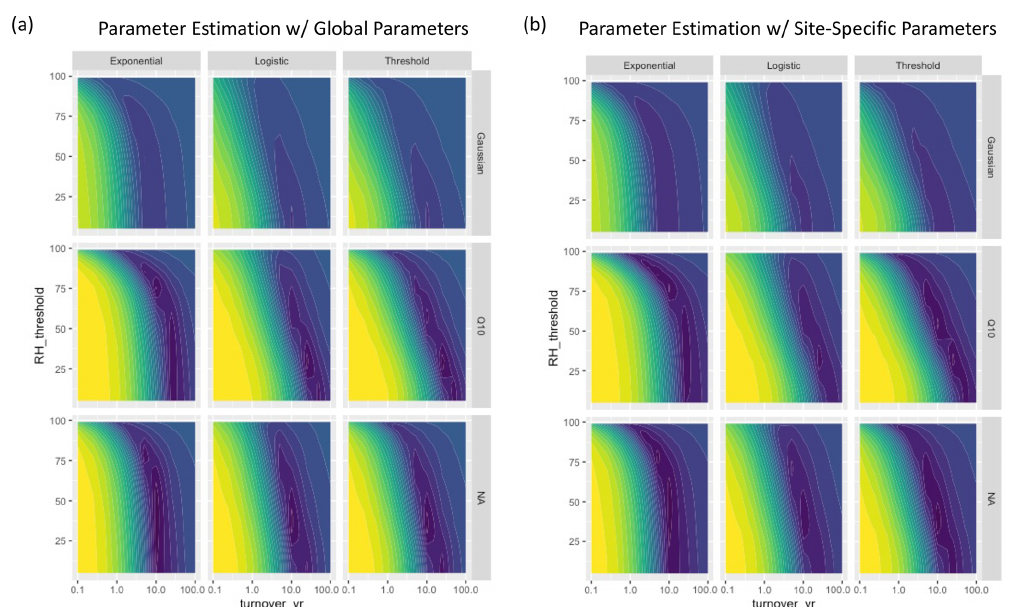
Figure A4. Parameter fits for the humidity-based moisture models using (a) global parameters that were fitted across sites, and (b) site- specific parameters. Colors represent AIC scores with purple denoting lower values and yellow denoting higher values. The left panel is identical to Fig. 3 in the main text.